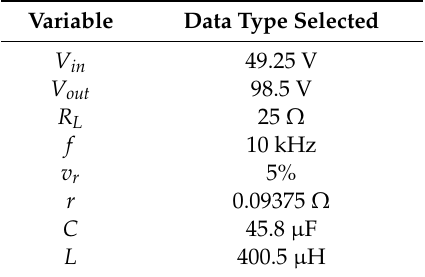
Table 3. Parameters obtained from the converter